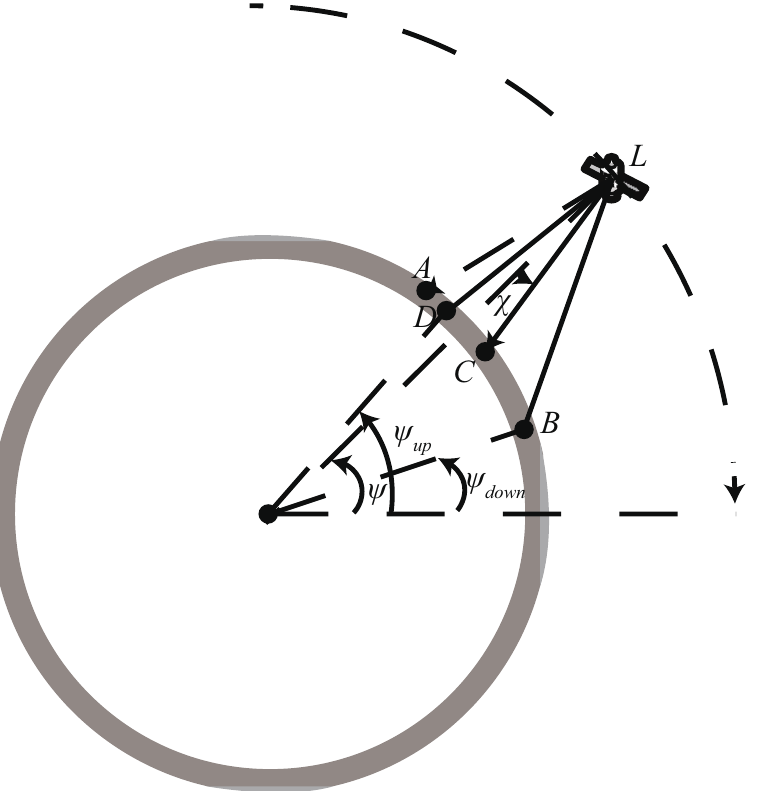
Figure 3. The coverage of LEO satellite in orbit